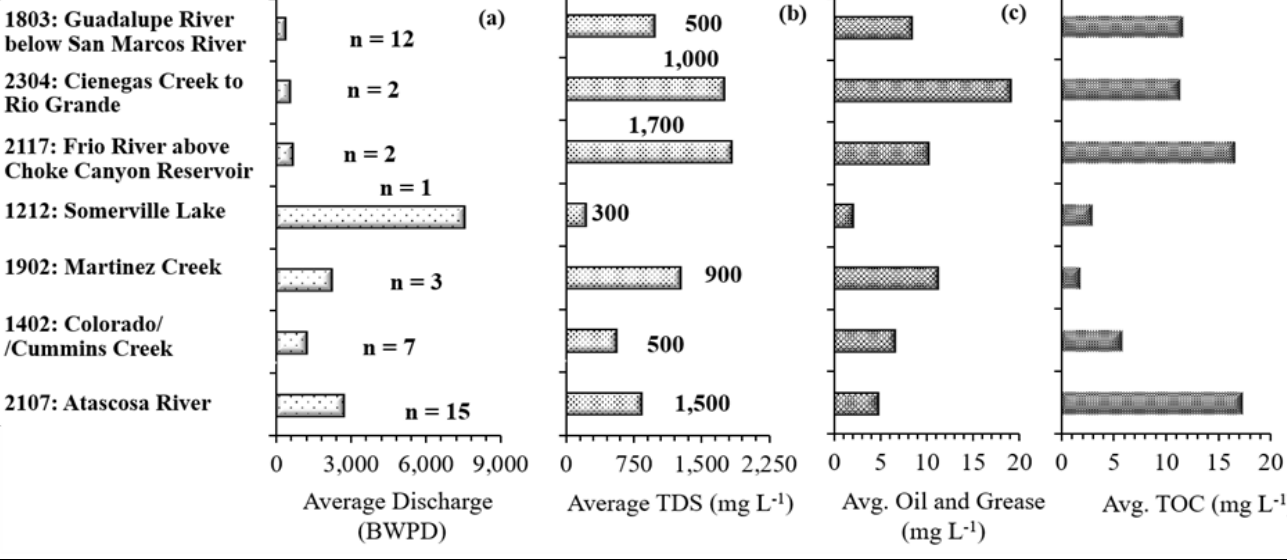
Figure 7. Average reported discharge volumes (a) and laboratory analyses levels of total dissolved solids (TDS) (b), oil and grease (c), and total organic carbon (TOC) (d) by segment. These data are based on the number of permitted discharges (i.e., n in (a)) reporting water quality data and discharge volumes from the Railroad Commission of Texas. The Texas Surface Water Quality Standard 307 segment criteria for TDS (in milligrams per liter [mg L -1 ]) is included next to the average measured TDS for each segment as shown on Figure 8.